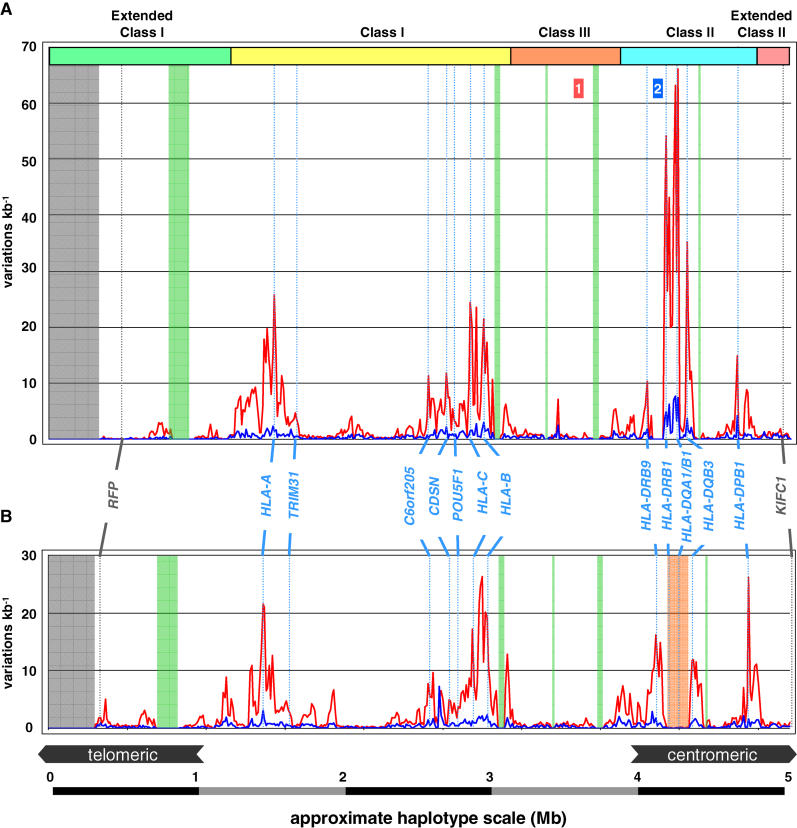
Positional Distributions of Variations between PGF and QBL and COX and QBL(A) Shows the distribution for PGF and QBL and (B) shows COX and QBL. MHC sequences were divided into 10-kb bins, and variations were calculated in each bin. Results are expressed as variations per 1 kb. Red and blue plots relate to SNP and DIP variations respectively. The sequence is interrupted by five gaps, shown as green vertical bars, where BACs encompassing these regions could not be identified from the clone library, which by comparison with PGF comprise a total of approximately 317 kb. The lengths and gene content of these gaps were as follows, from left to right: 159 kb including OR2U1P to OR12D2; 51 kb containing HCP5; 26 kb containing C6orf26, C6orf27, and the three exons of 3′ end of MSH5; 53 kb containing CREBL1, FKBPL, and six exons of the 5′ end of TNXB; and 27 kb containing HLA-DOB. These gaps do not represent large genomic deletions within the QBL haplotype since exonic sequence from selected genes within these regions were successfully amplified from QBL genomic DNA and sequenced to confirm their identity. The grey shaded area at the telomeric end of the map represents sequence for which overlap was not obtained and was therefore outside the area that was compared.Boundaries of the class I, II, and III regions are shown. The positions of RFP and KIFC1 that define the ends of the MHC haplotype sequencing project are indicated. Landmark genes are labelled in blue. Regions 1 and 2 are the RCCX module and the HLA-DRB region, respectively. The HLA-DRB3 and HLA-DQB3 region, which shows little variation between COX and QBL haplotypes, is shaded in orange.